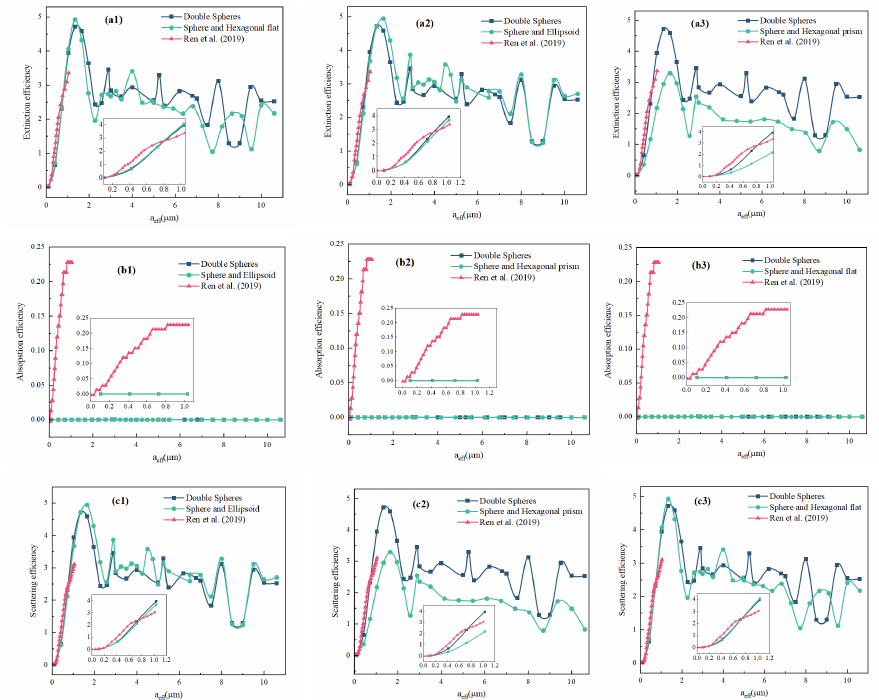
Figure 3. Variation of the extinction efficiency, absorption efficiency, and scattering efficiency of ag- glomerated ice crystal particles with effective size for the different agglomeration models [8]. ( a1 – a3 ) changes in extinction efficiency; ( b1 – b3 ) changes in absorption efficiency; ( c1 – c3 ) changes in scattering efficiency.